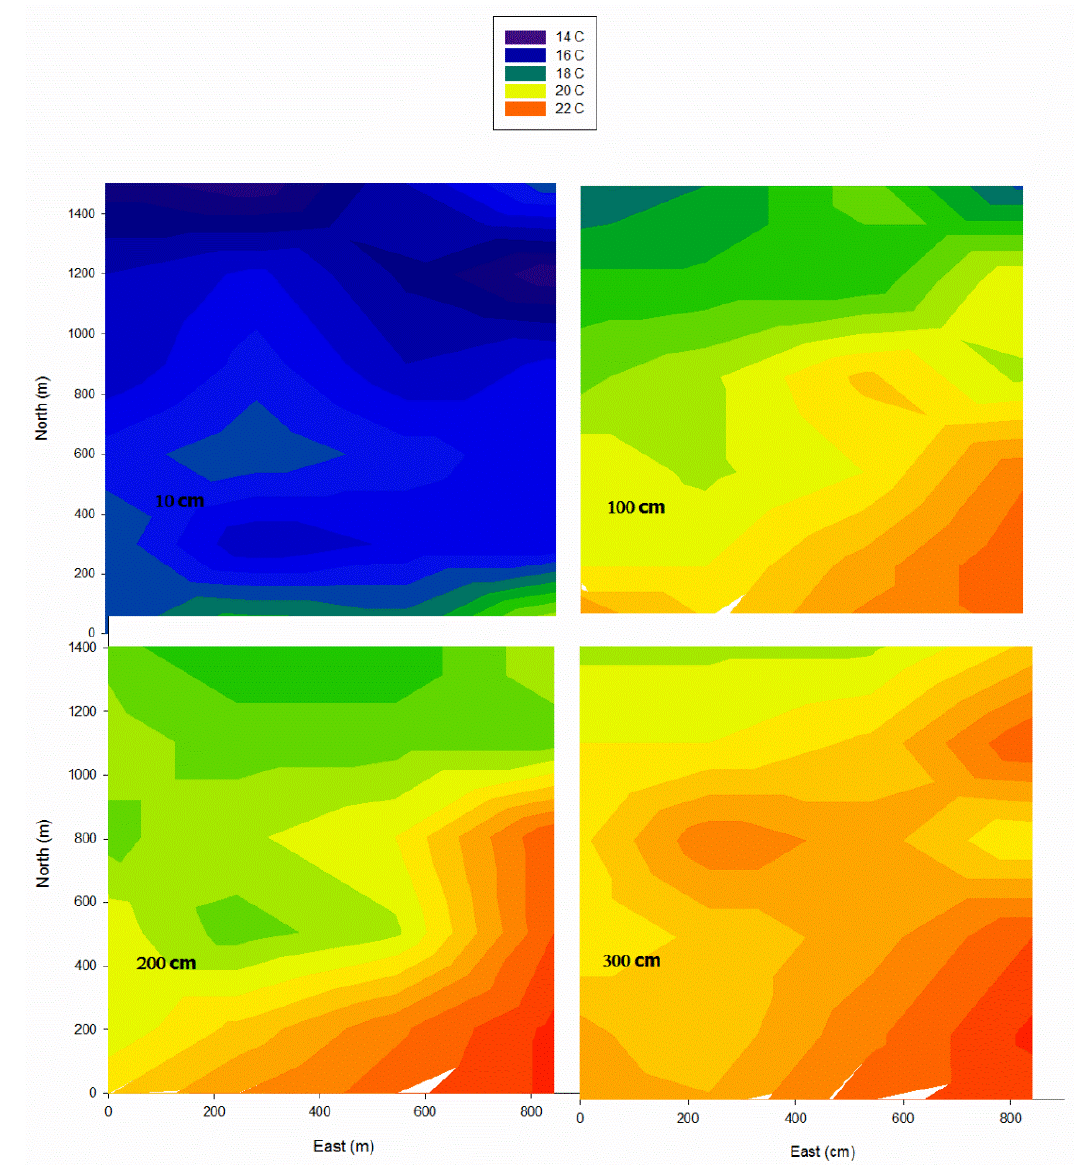
Figure 10. Air temperature at 0700 hour on 30 May at heights of 10, 100, 200 and 300 cm within the down gradient creosote bursage plant community. The solar facility was located approximately 100 m up gradient from the lower west to east edge of the monitoring area (see site location map).